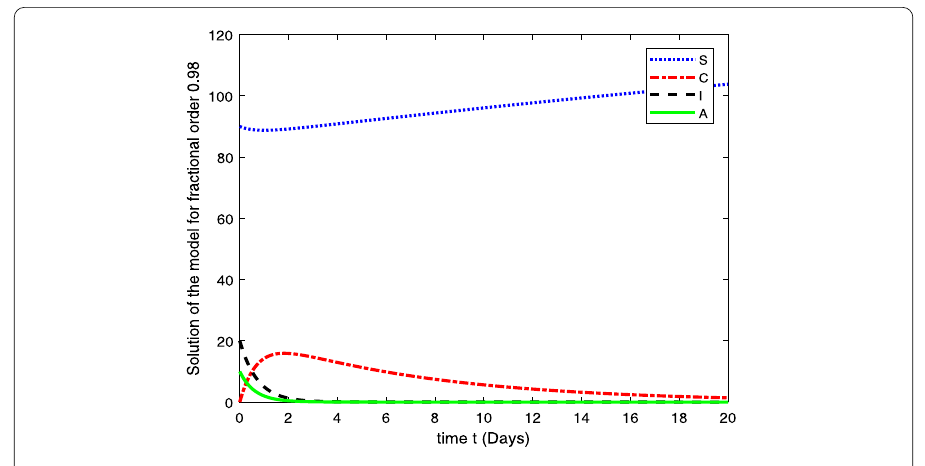
Figure 8 The solution for (1) for S , I , C , A , keeping h = 0.1 and α =